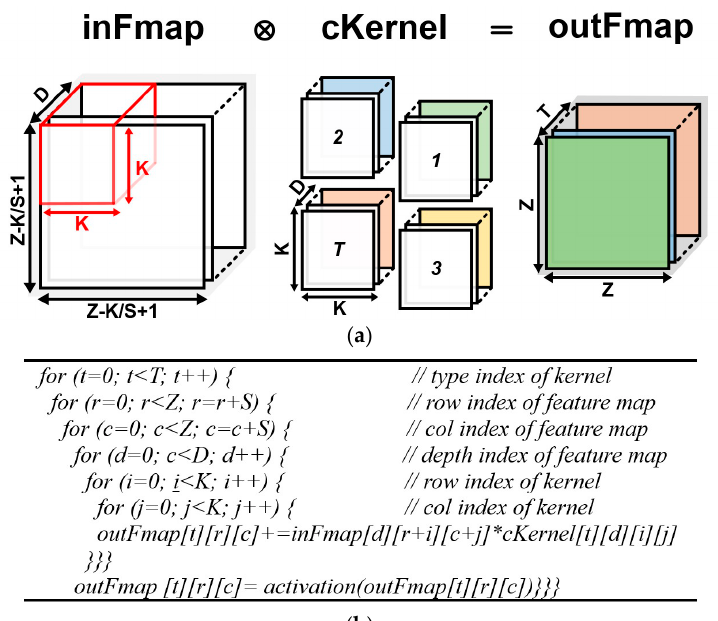
Figure 1. Convolution between convolution kernels and an input feature map. ( a ) Illustration of the convolution operation between one feature map and T type convolution kernels; ( b ) pseudo code of the convolution layer.